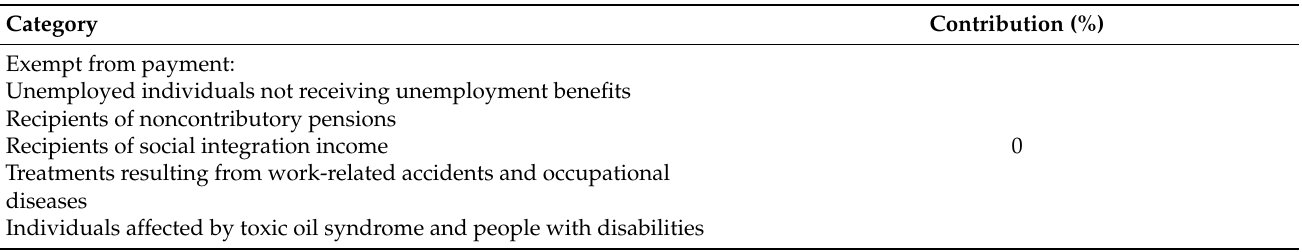
Table 1. Patient contribution to pharmaceutical services after implementation of the pharmaceutical copayment (Royal Decree Law 16/2012 and Royal Decree